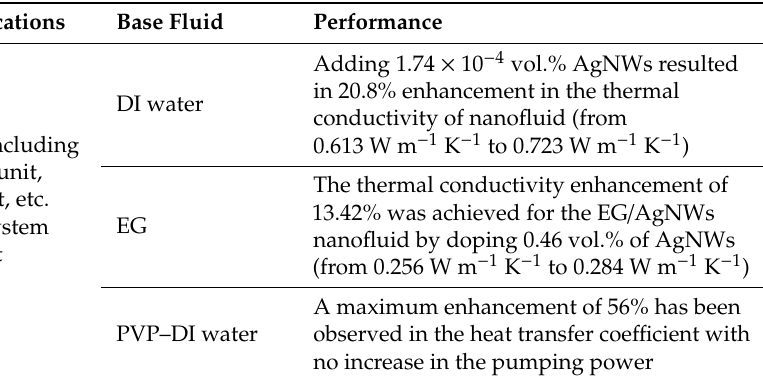
Table 3. Summary of AgNWs for improving the thermal transport of the base